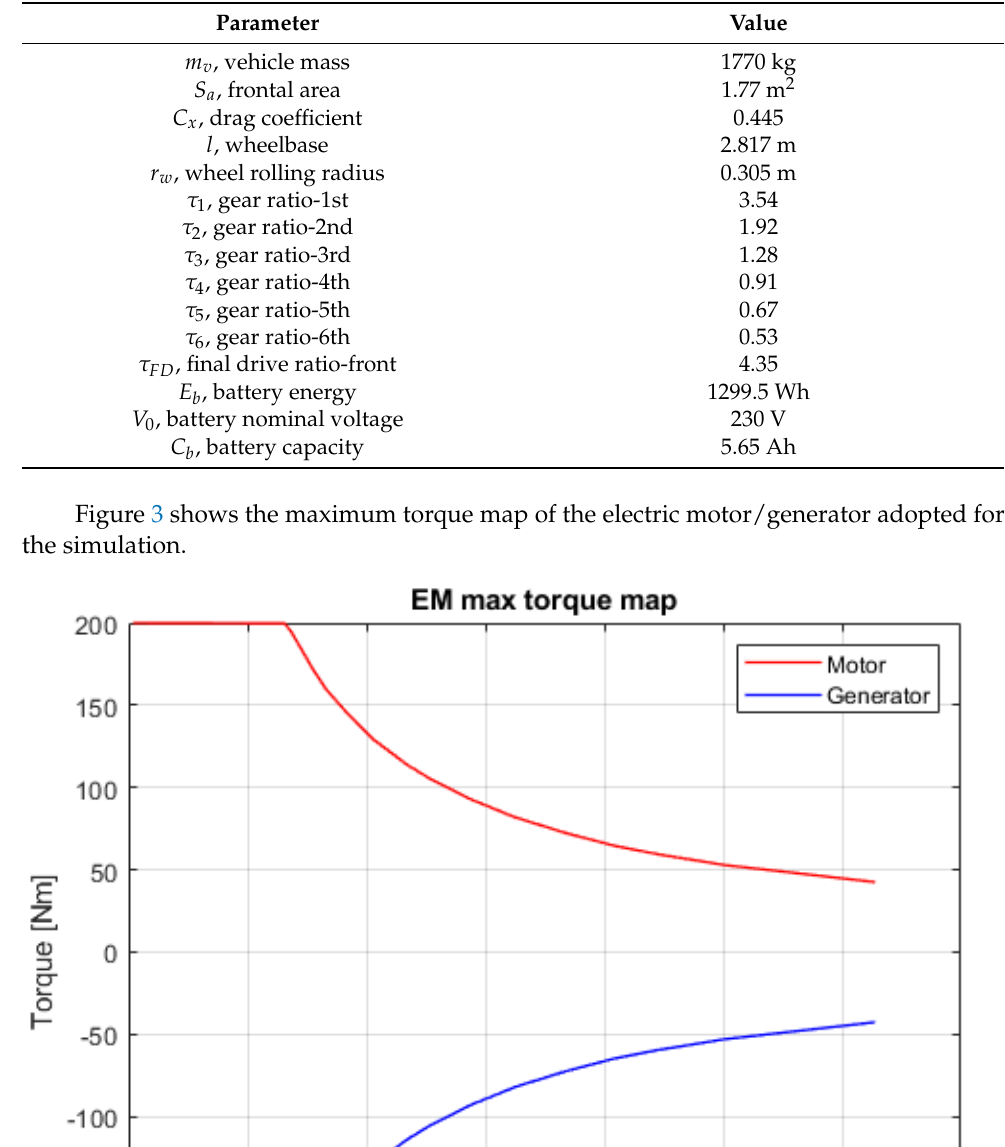
Table 2. HEV geometry and transmission main parameters.